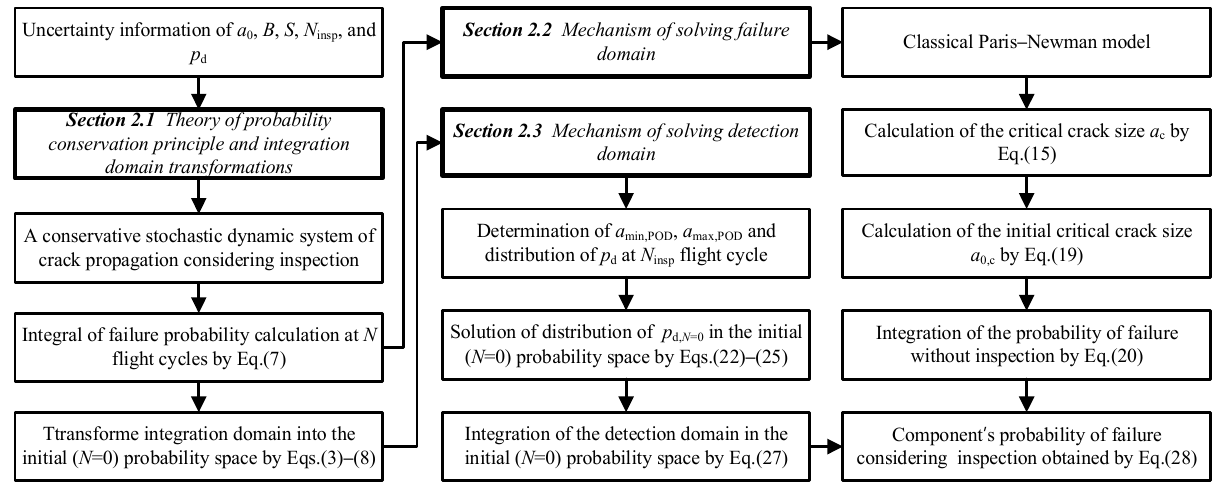
Figure 9. Flowchart of the presented efficient numerical integration algorithm for risk assessment considering in ‐ service inspection.